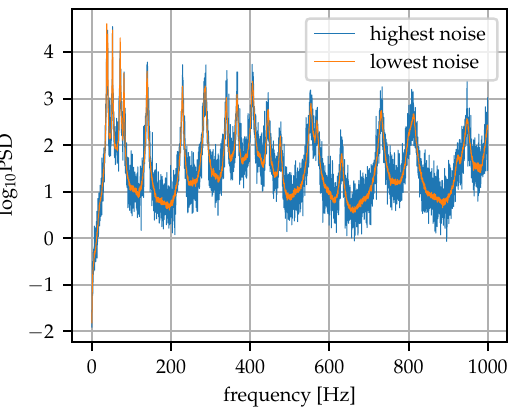
Figure 2. An example spectrum with maximum (factor 0.06) and minimum (factor 0.006) added